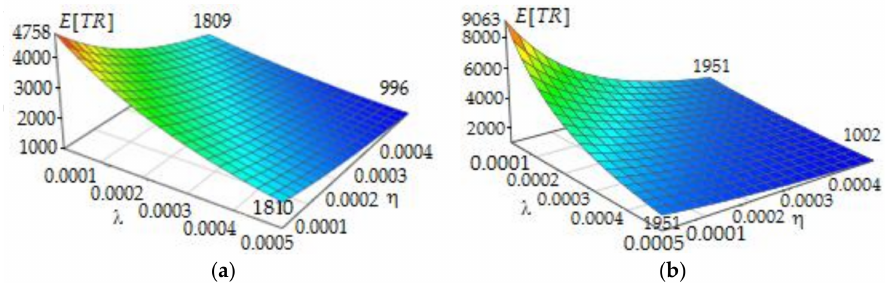
Figure 4. ( a ) A 3D plot of the dependence of the mean time between unscheduled removals (MTBUR) on the rates of permanent failures and intermittent faults when T = 5000 h; ( b ) A 3D plot of the dependence of the MTBUR on the rates of permanent failures and intermittent faults when T = 10,000